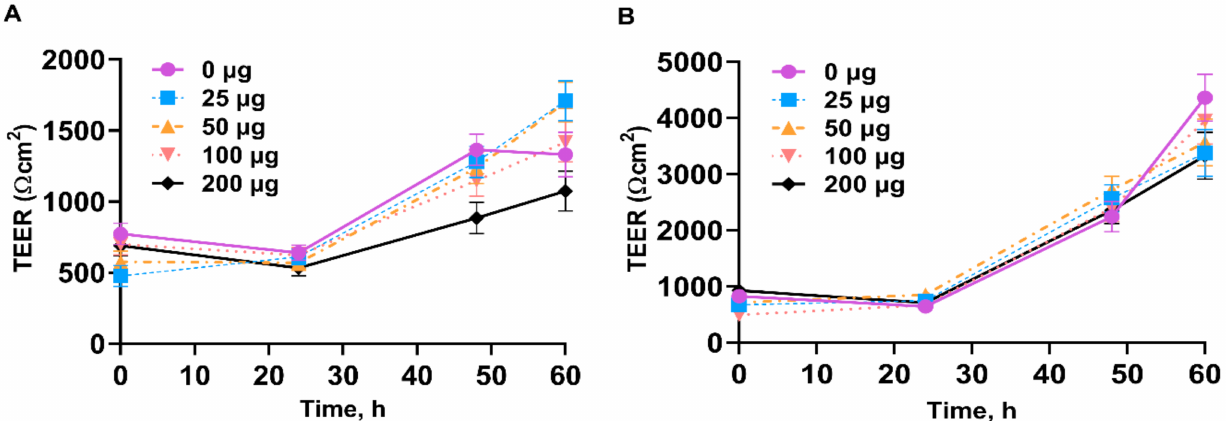
Figure 3. Peppermint oil ( A ) and spearmint oil ( B ) effects on the transepithelial electrical resistance (TEER) of IPEC-J2 cells. The tested doses of peppermint oil ( A ) and spearmint ( B ) were 0, 25, 50, 100, 200 µ g/mL.